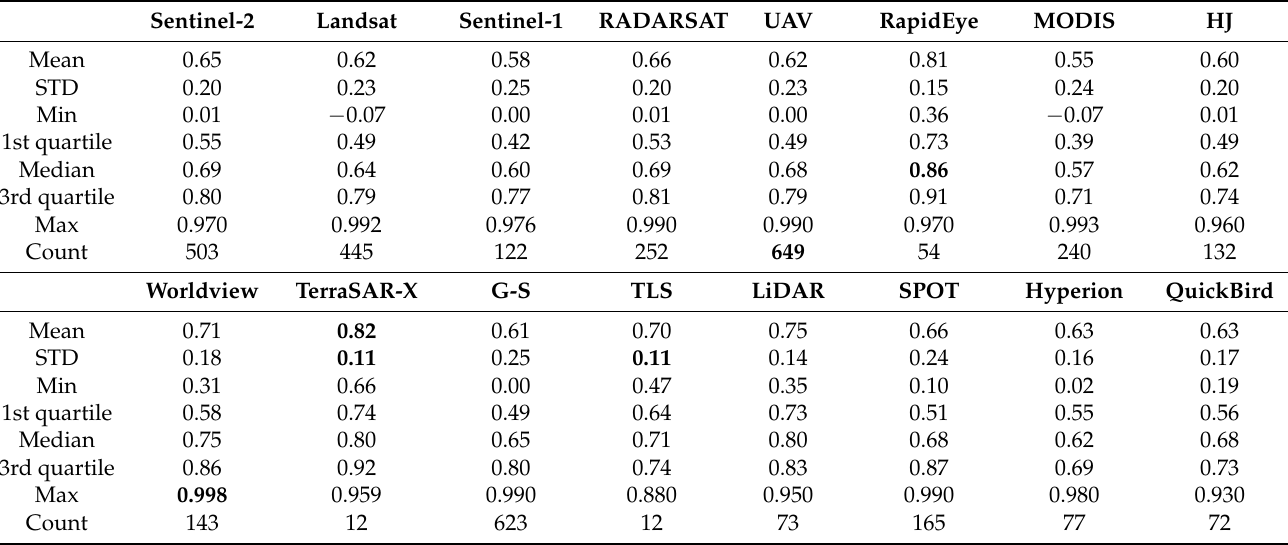
Table 10. Statistical analysis of R 2 in various specific